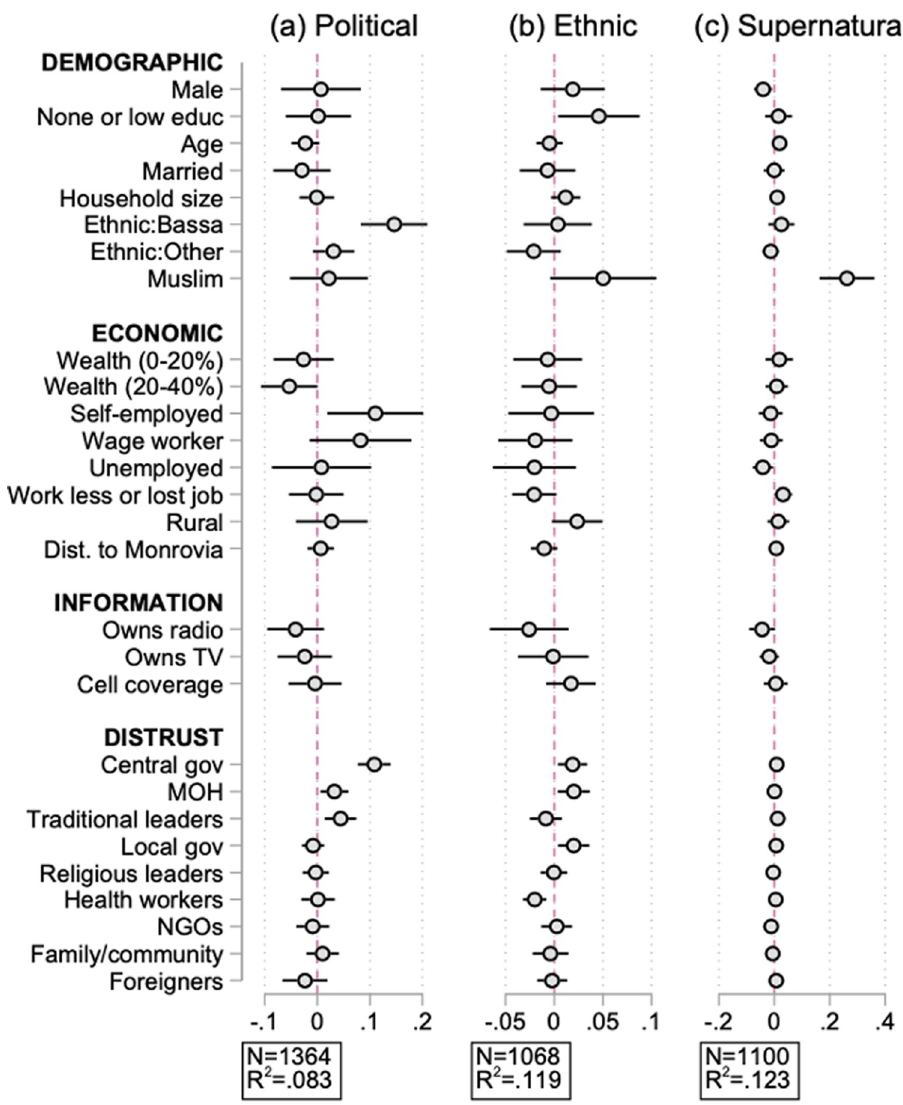
Fig 3. Determinants of the misinformed, by type of beliefs. Dots represent the marginal effects from Eq 1. Spikes give 95% confidence intervals. “Political” refers to individuals reporting the government was responsible for bringing Ebola to Liberia. “Ethnic” refers to individuals reporting foreign NGOs, UNMIL, White, Fula, Kissi, or Mandingo people bringing Ebola. “Supernatural” refers to individuals reporting that God or witches were responsible for bringing Ebola. Refer to Fig 1 notes for a description of the